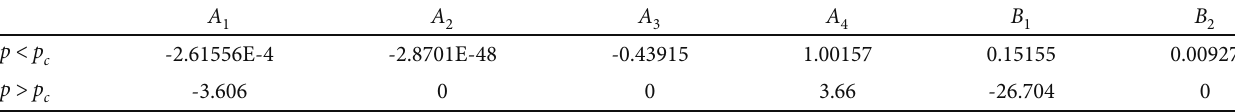
compressibility factor. 2